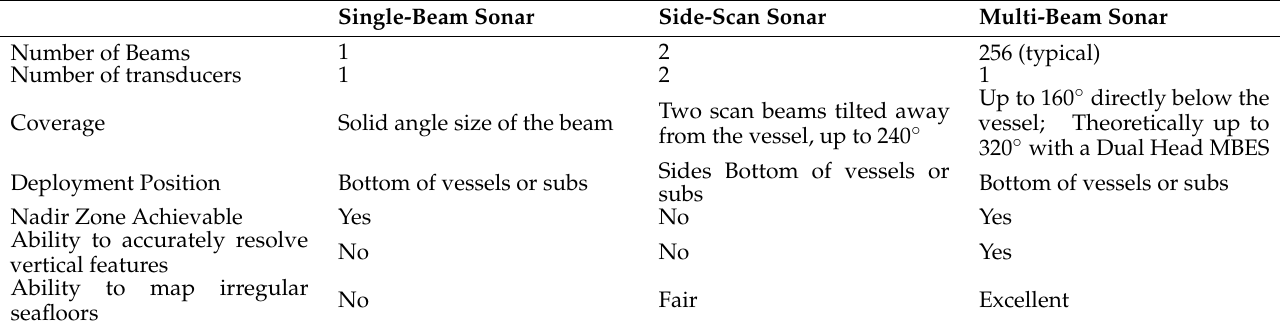
Table 1. Comparison of single beam, side scan, and multi-beam sonar [22,23]. Single-Beam Sonar Side-Scan Sonar Multi-Beam